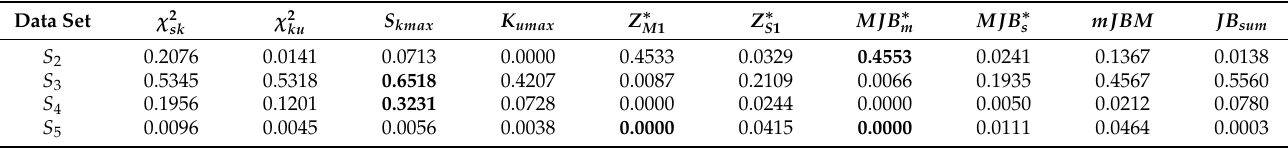
Table 7. p -values of the ten statistics of single proton emission computed tomography (SPECT) heart data. S kmax K Data Set χ 2 χ 2 sk ku